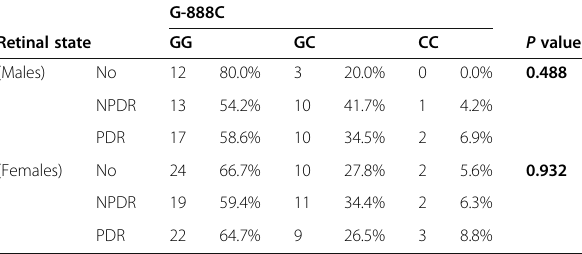
Table 5 The distribution of genotype frequency of G-888C polymorphism of SDH gene in relation to severity (NPDR and PDR) of retinopathy in both